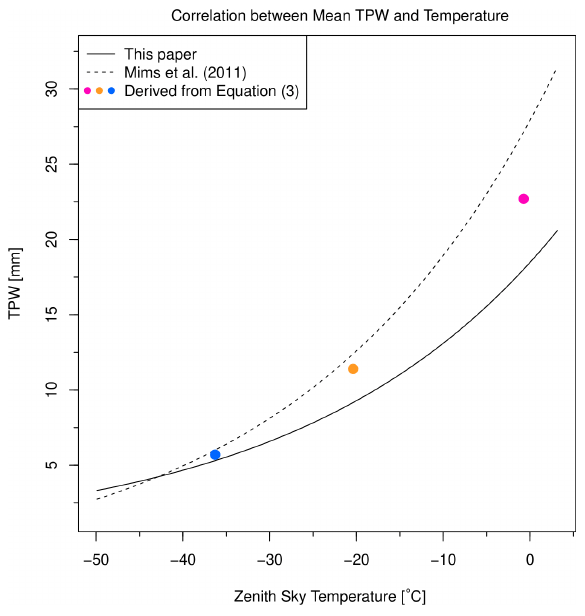
Figure 8. Zenith sky temperature versus PWV for the best fit to measurements from this study (solid curve) and the best fit from Mims et al. (2011) using the expression 30 . 55 e 0 . 035 x − 2 . 63 (dashed curve). Results from MODTRAN6 radiance calculations for average 7–10µm effective brightness temperature (blue, orange, and purple solid circles) are plotted for comparison. The model re- sults include the combined effects of changes in PWV and air tem- perature on the effective brightness temperature, as expressed by Eq.